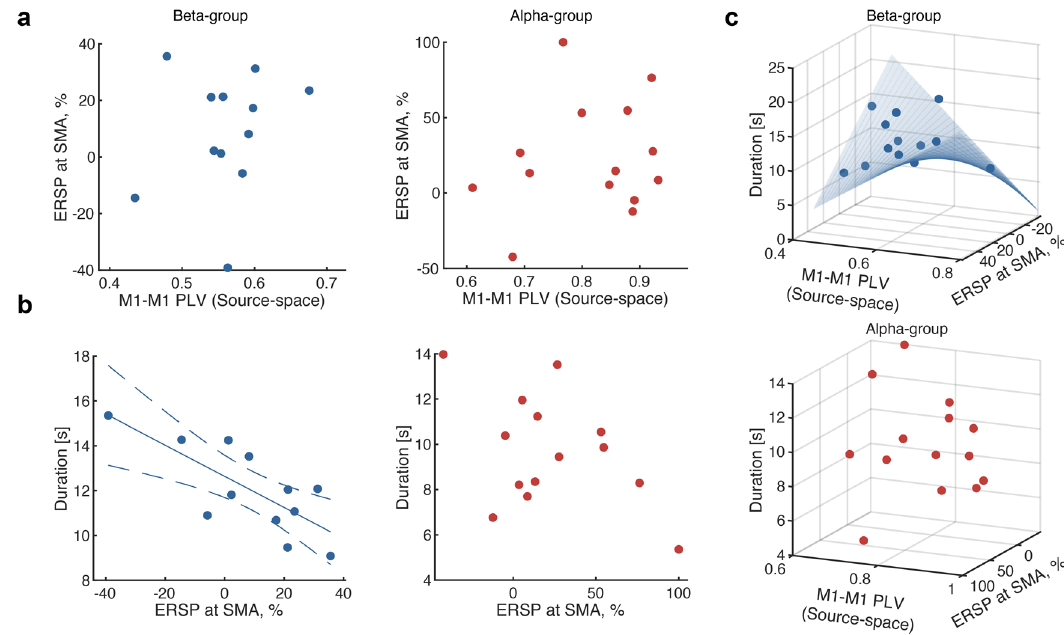
Fig. 3 Pre-movement cortical interaction explains the behavioral performance. a Correlation analysis of M1-M1 phase synchrony and event-related spectral perturbation (ERSP) at SMA. No signi fi cant correlation was observed in beta and alpha groups (Pearson ’ s correlation test, beta: r = 0.21, p = 0.50; alpha: r = 0.20, p = 0.49). b Correlation analysis of ERSP at SMA and duration of anti-phase bimanual tapping. Signi fi cant correlation was only observed in the beta-group (Pearson ’ s correlation test, beta: r = − 0.75, p = 0.0048; alpha: r = − 0.45, p = 0.10). c Multiple regression analysis for the performance and pre-movement cortical activity patterns. M1-M1 PLV, ERSP at SMA, and their interaction were signi fi cantly associated with performance only in the beta- band ( Top : beta-band: p = 0.007 (vs. constant model); Bottom : alpha-band: p = 0.29 (vs. constant model), statistical values in the main text). The blue curved surface represents the regression